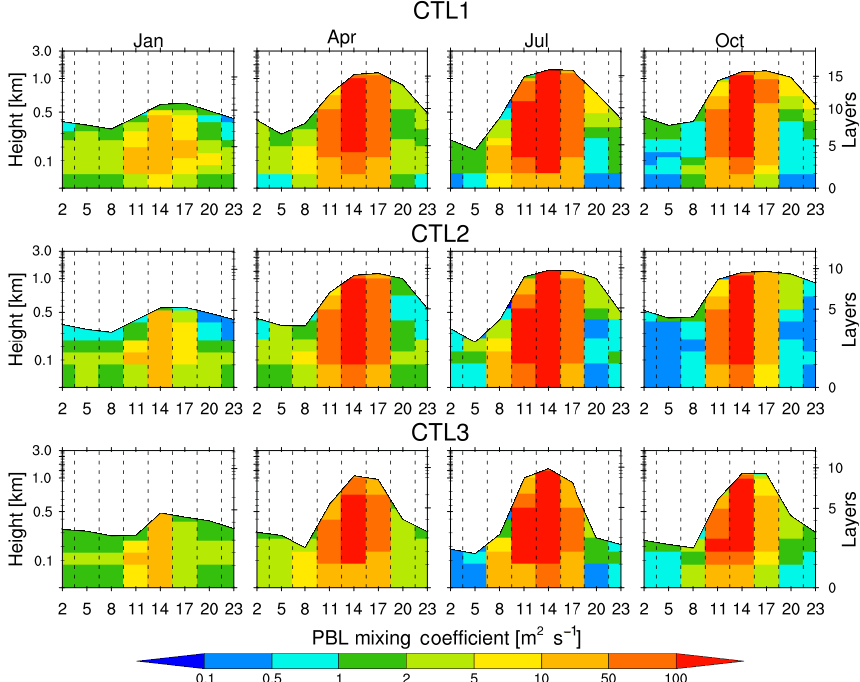
Figure 6. Diurnal variation of PBLH (planetary boundary layer height) and PBL mixing coefficient below PBLH averaged over Hefei for January, April, July, and October of 2018 from experiments CTL1, CTL2, and